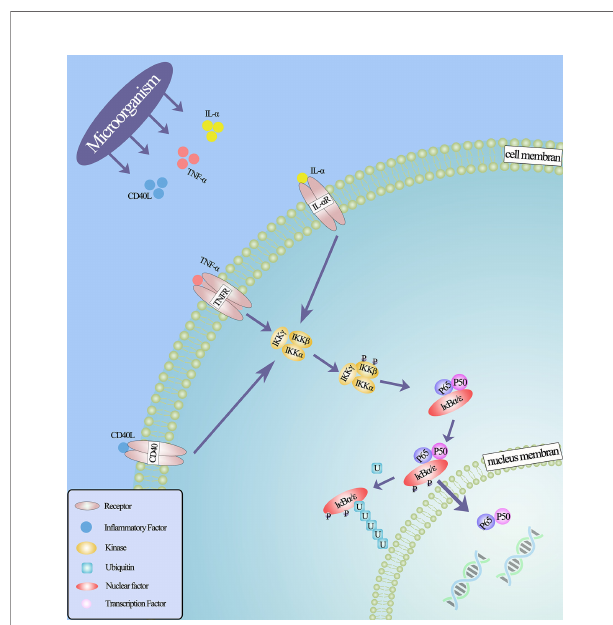
FIGURE 2 | NF- k B classical signal pathway under the action of microorganisms. Microorganisms stimulate in fl ammatory cells to secrete in fl ammatory factors that bind to related receptors and cause con fi guration changes, such as IL- a (IL-6, IL-8), TNF- a , CD40, lipopolysaccharide and so on, thus activating I k B kinase. This leads to the phosphorylation and ubiquitin of I k B protein, the degradation of I k B protein and the release of NF- k B dimer. Through various post-translational modi fi cations, NF- k B dimer is further activated and transferred to the nucleus to bind the target gene and promote the transcription of the target